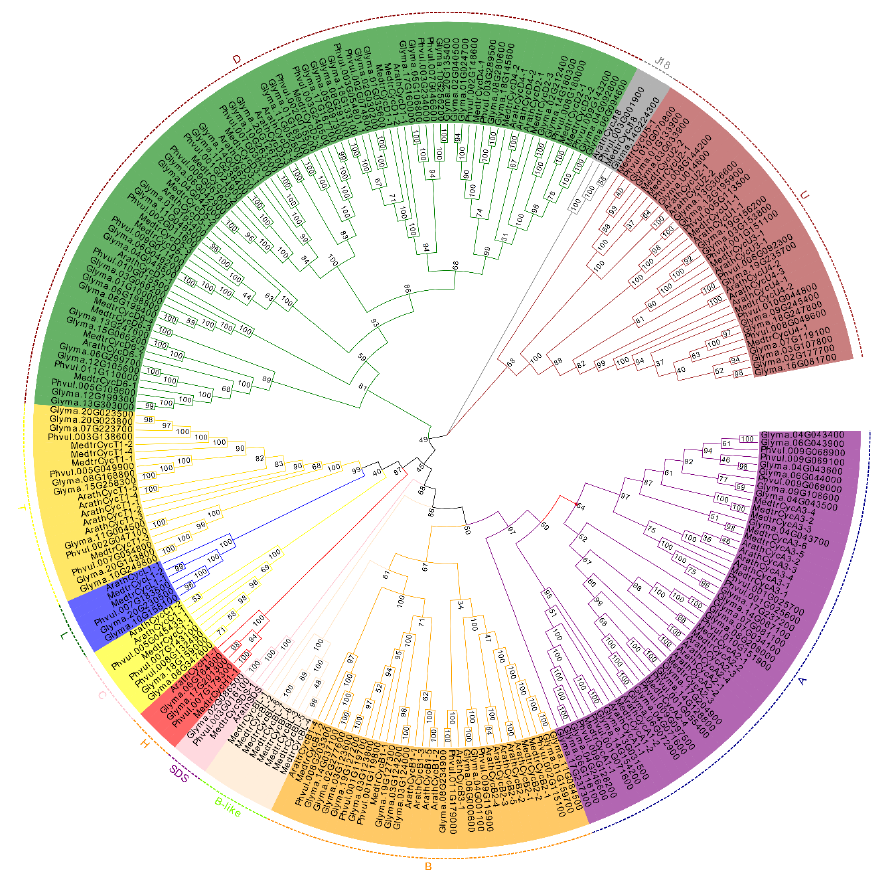
Figure 1. Phylogenetic tree analysis of cyclins retrieved in Medicago truncatula , soybean, common bean and Arabidopsis . The complete protein sequences for 261 cyclins were aligned by ClustalW, and the phylogenetic tree was constructed using MEGA 7.0 by the neighbor-joining method with 1000 bootstrap replicates. All cyclins were classified into 10 distinct groups based on the nomenclature of Arabidopsis cyclins (from A to D, H, L, T, U, SDS and J18) and were distinguished by di ff erent